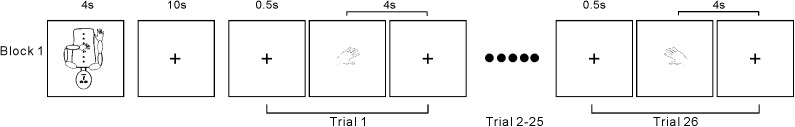
Time course of the first block. The other 19 blocks were the same as block 1.